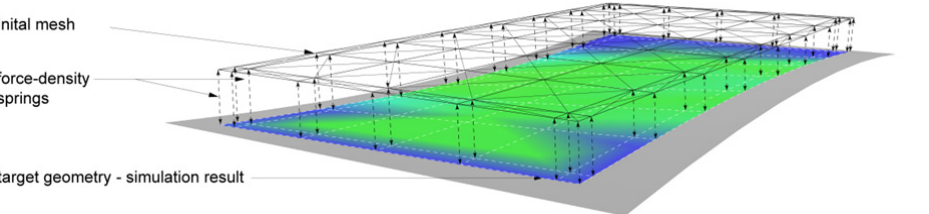
Fig. 3 Approximate bending on target